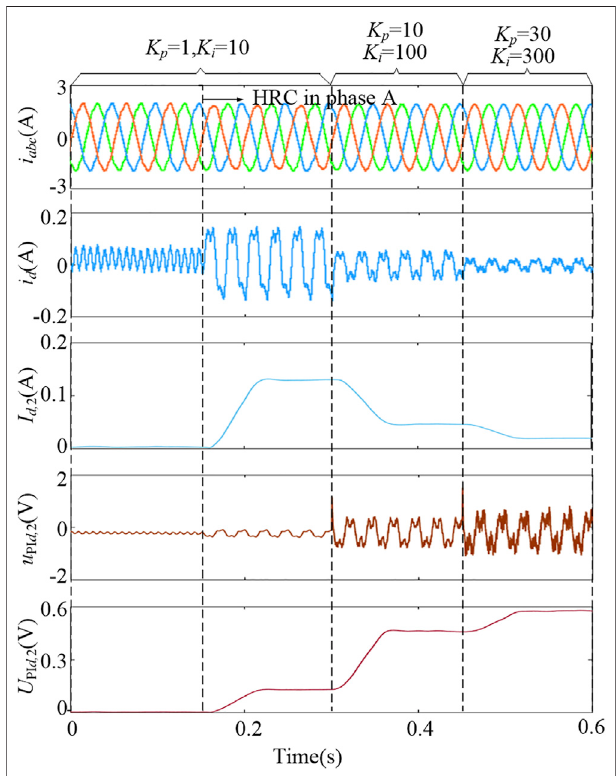
FIGURE 10 | Waveforms of the PM machine with different current closed-loop controller parameters.